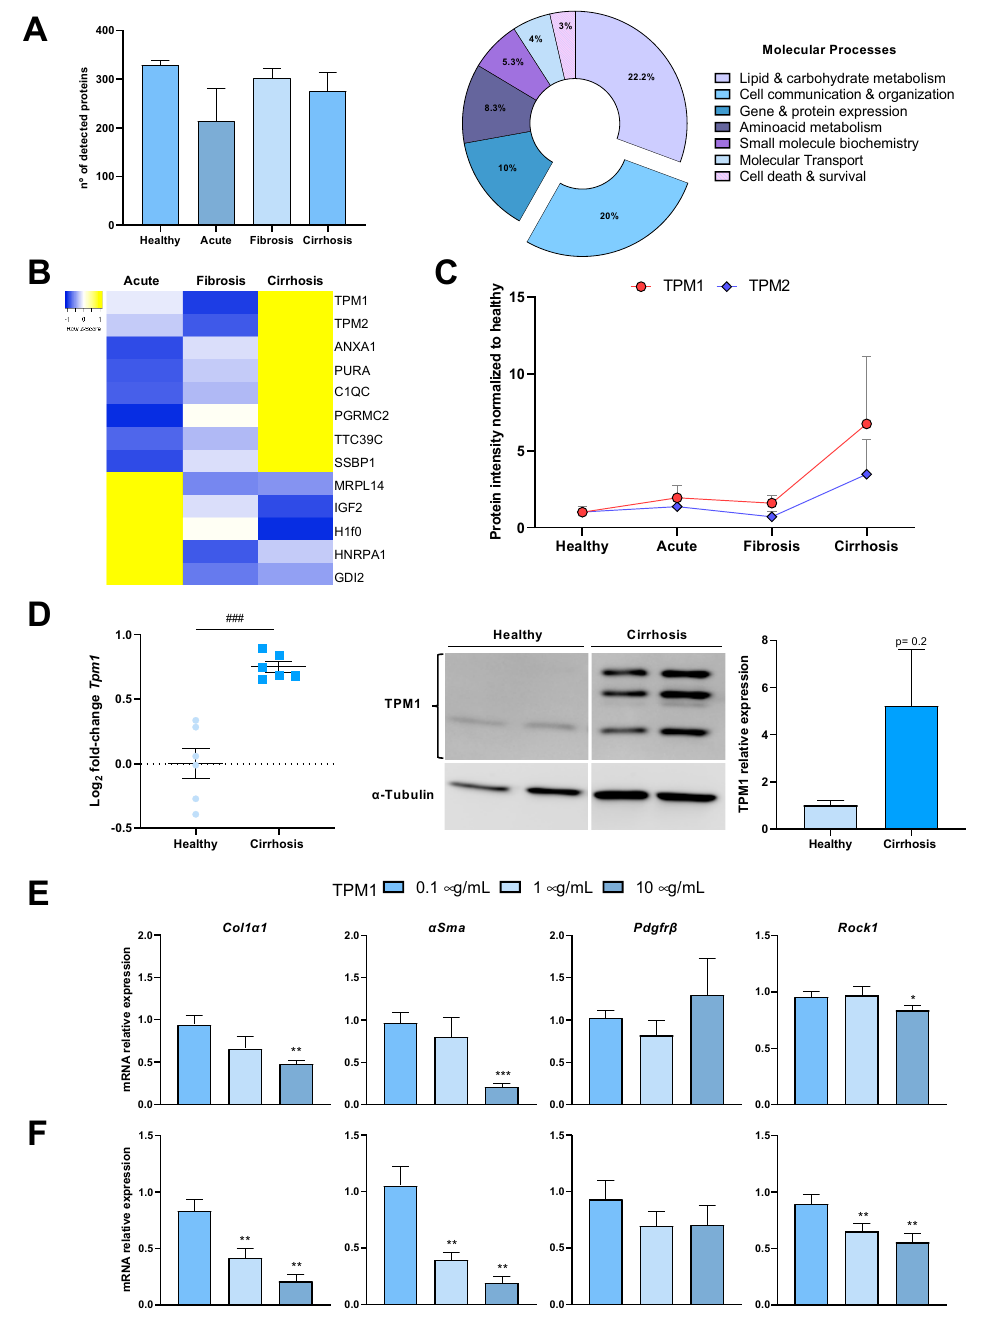
Figure 5. LSECs extracellular vesicles proteomics during CLD progression. ( A ) Left, number of proteins detected in LSECs-derived small EVs at each stage of CLD progression. Right, cellular processes of deregulated proteins in cirrhotic LSECs EVs analysed by Ingenuity Pathway Analysis. ( B ) Heatmap of the top up- (yellow) and down-regulated (blue) proteins of LSECs EVs during CLD progression and, ( C ) graphical representation of Tpm1 & 2 gene expression in LSECs EVs across CLD. ( D ) Left, mRNA expression of Tpm1 in healthy and CCl 4 -cirrhotic LSECs. Values are represented in log2 fold-change. Right, western blot representative image of TPM1 in healthy and CCl 4 -cirrhotic LSECs, and corresponding quantification. ( E ) mRNA expression of depicted genes in in vitro activated HSCs and ( F ) primary isolated cirrhotic CCl4-HSCs exposed to different concentrations of recombinant TPM1 for 24 h. Red dot lines represent vehicle-treated cells. Results derive from n = 9 isolations ( A , B ), n = 9 independent samples ( C ), n = 6 independent isolations ( D ) and n = 3–5 independent experiments ( E , F ). ### p < 0.001 t test between cirrhotic and healthy group; * p < 0.05, ** p < 0.01 and *** p < 0.001, t test (Mann-Whitney U test for non-parametric variables) for differences between each group and the corresponding control group.